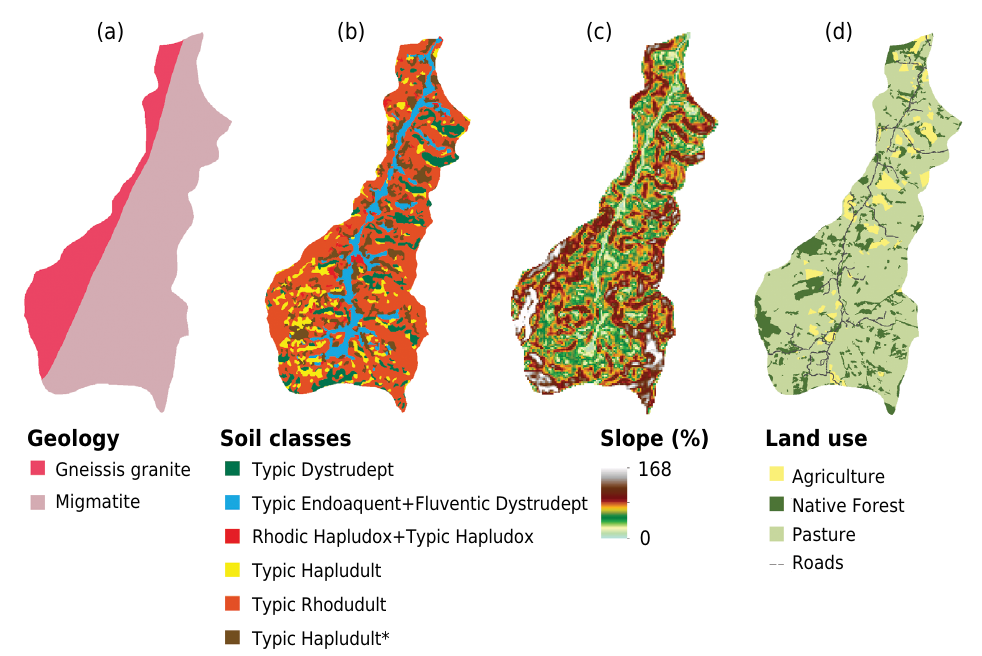
Figure 2. Geology (a), soil types (b), slope (c), and land use (d) that predominate in the Posses catchment. Source: adapted from CPRM (2015), Bispo et al. (2017), and Silva et al.